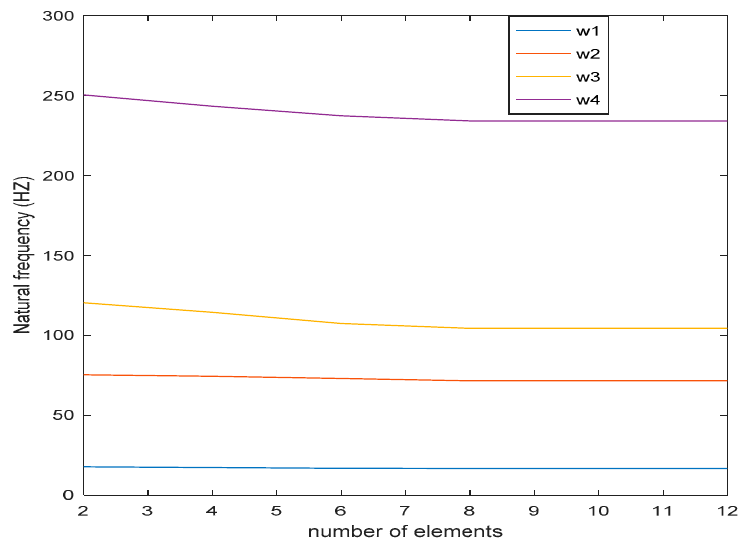
Figure 5. Chart of influence of element number on natural frequency of ACLD thin plate.